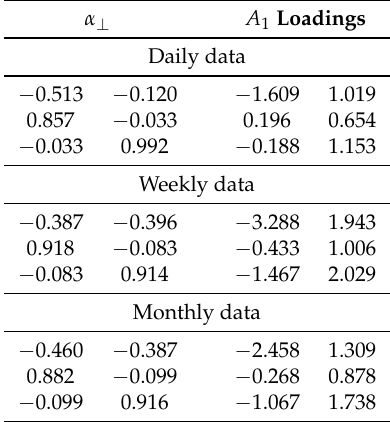
Table 11. Estimated parameters for the Gonzalo–Granger permanent-transitory decomposition of coal, gas and Brent given by Equations (4) and (5). α